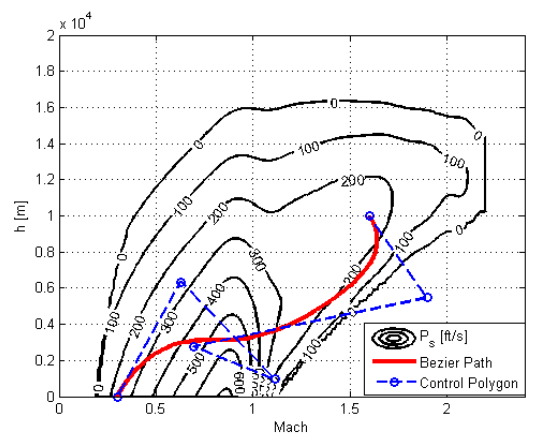
Figure 2. Climb path (red) generated using a Bezier spline, plotted over Specific Excess Power contours. The spline’s control points are shown in blue.